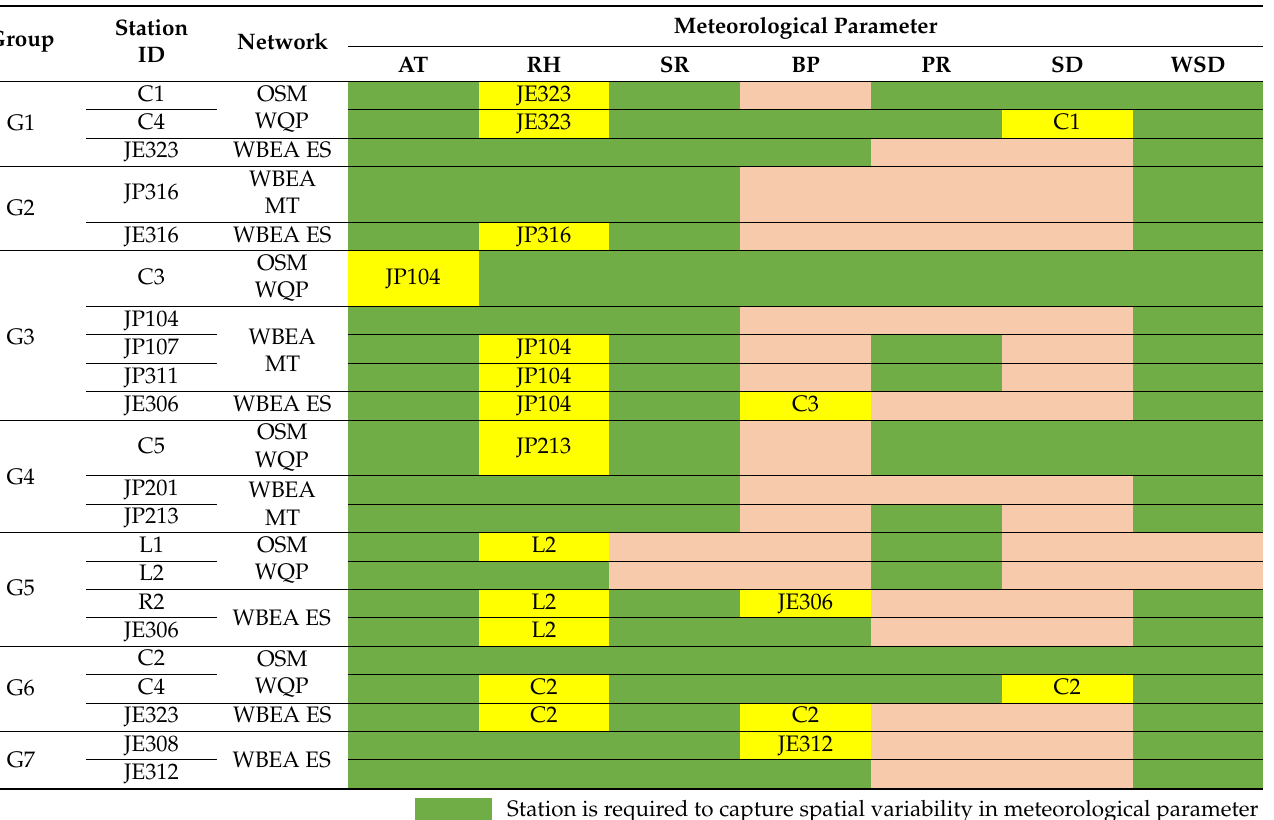
Table 6. Group-specific required stations for each of the meteorological